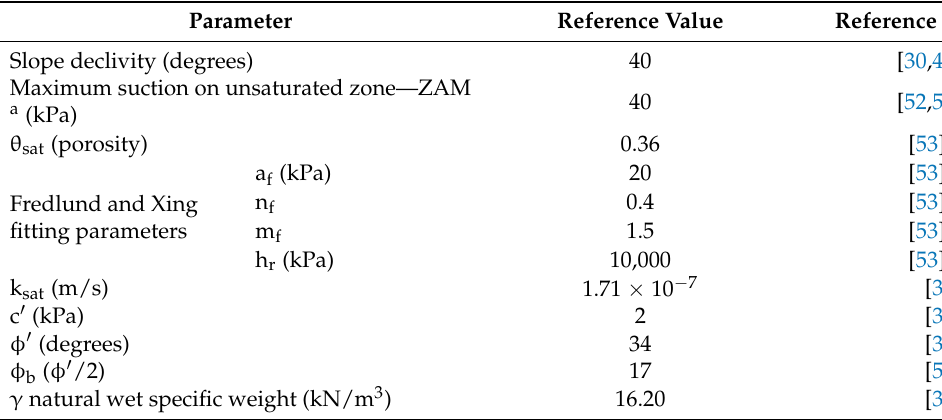
Table 1. Reference parameters and